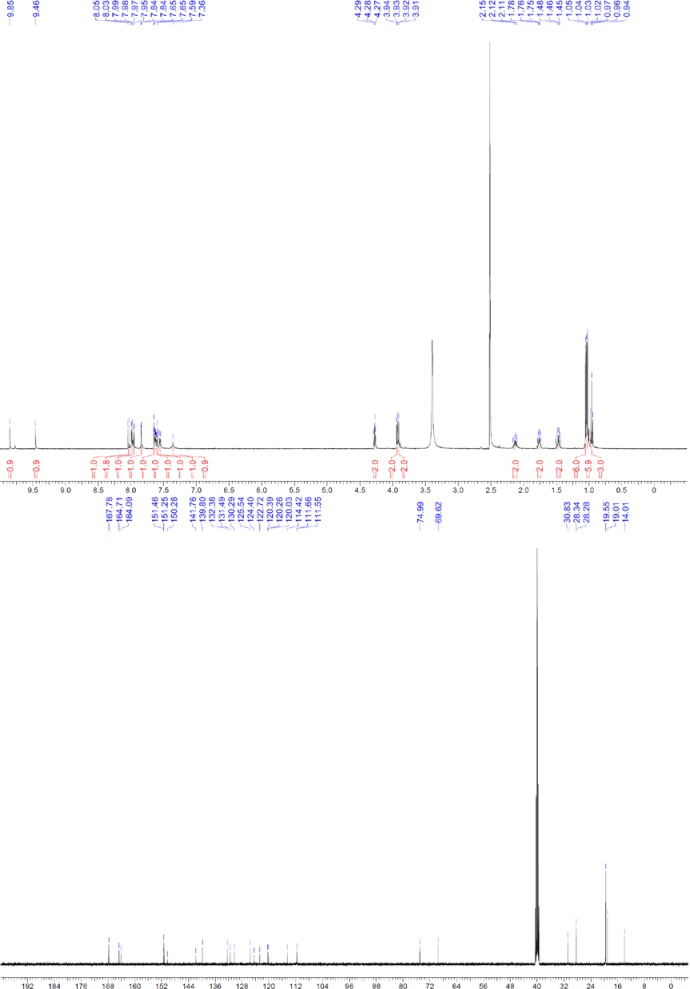
1H and 13C NMR of ERX-9.